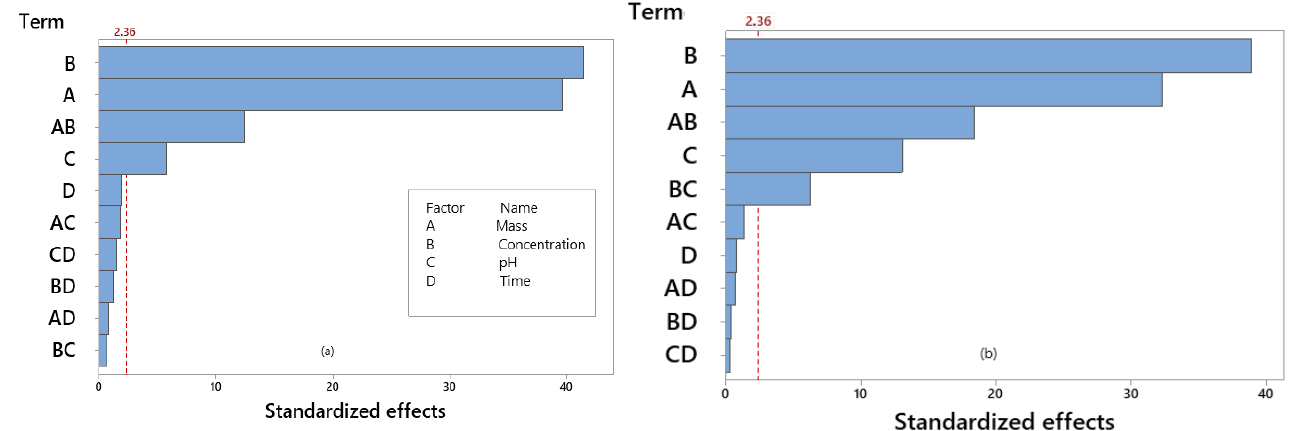
Figure 6. Pareto chart—Influence of the independent variables on the Q t response variable of the functionalized palygorskite clay ( a ) acid and ( b ) organic (bars beyond the dashed line are statistically significant at the 95% confidence level).